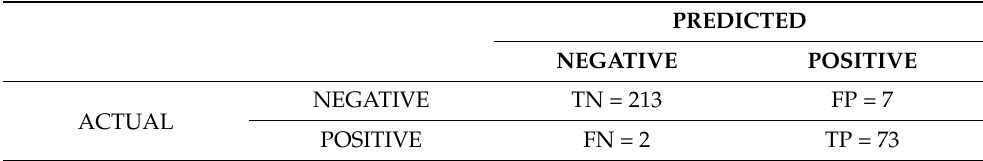
Table 4. Confusion matrix when class 4 is denoted as